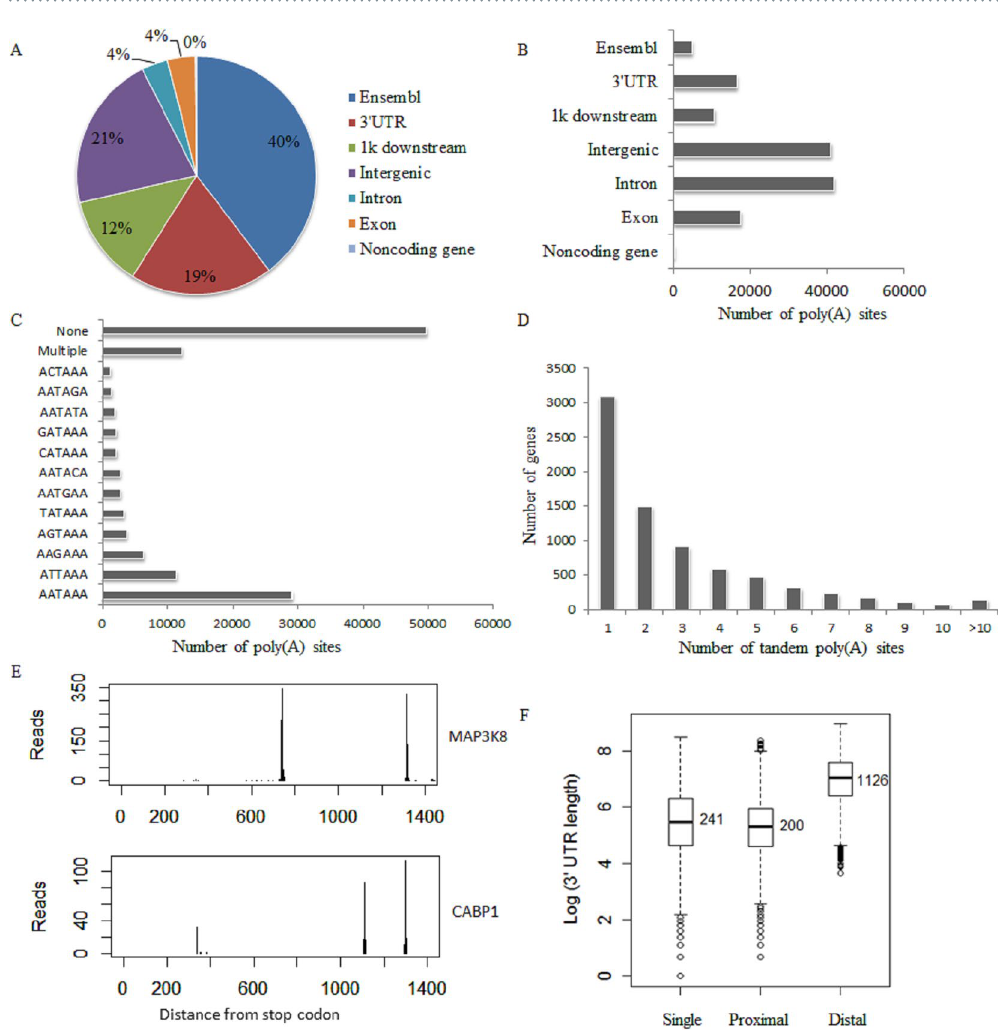
Figure 2. Sequencing reads and poly(A) sites in host genes. ( A ) Genomic locations of sequencing reads. The genomic annotation of host was downloaded from UCSC by selecting Ensembl Genes track and the 3 ′ UTR tail of these genes were annonated as Ensembl. ( B ) Distribution of poly(A) sites in genome. ( C ) Signal using of poly(A) sites. If none of common hexamers was identified in upstream of poly(A) sites, it was classified into none category. ( D ) Genes with different numbers of tandem poly(A) sites. ( E ) Examples of genes with two and three 3 ′ UTR isoforms (MAP3K8 and CABP1). ( F ) Histograms of the distances between stop codons and poly(A) sites in genes with single poly(A) sites and distances between stop codons and closest poly(A) sites and longest poly(A) sites in genes with APA in the 3 ′